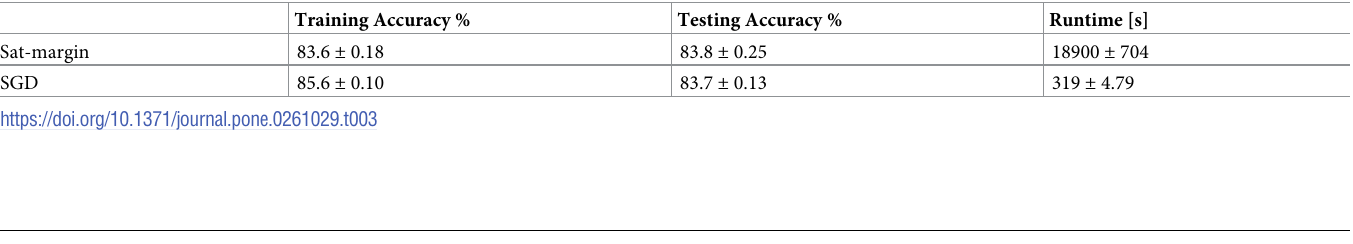
Table 3. Average results for Experiment 4 over five runs with standard